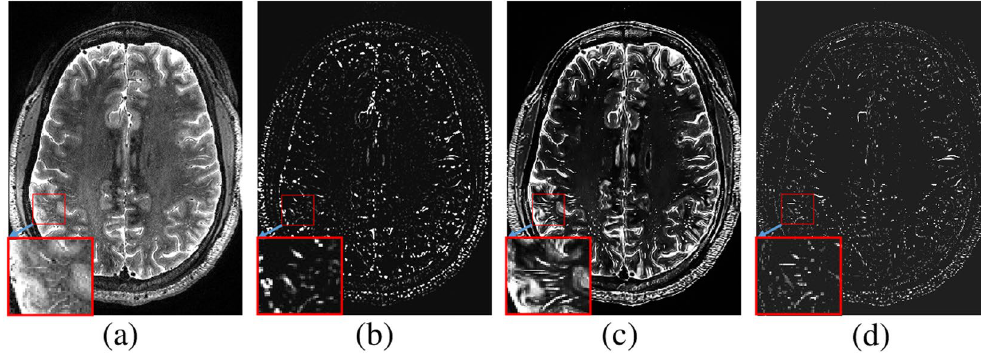
Figure 6. Vesselness estimation on the original image and our enhanced and denoised image. ( a ) Original image, ( b ) estimated vesselness map from ( a , c ) our enhanced and denoised image, and ( d ) estimated vesselness map from ( c